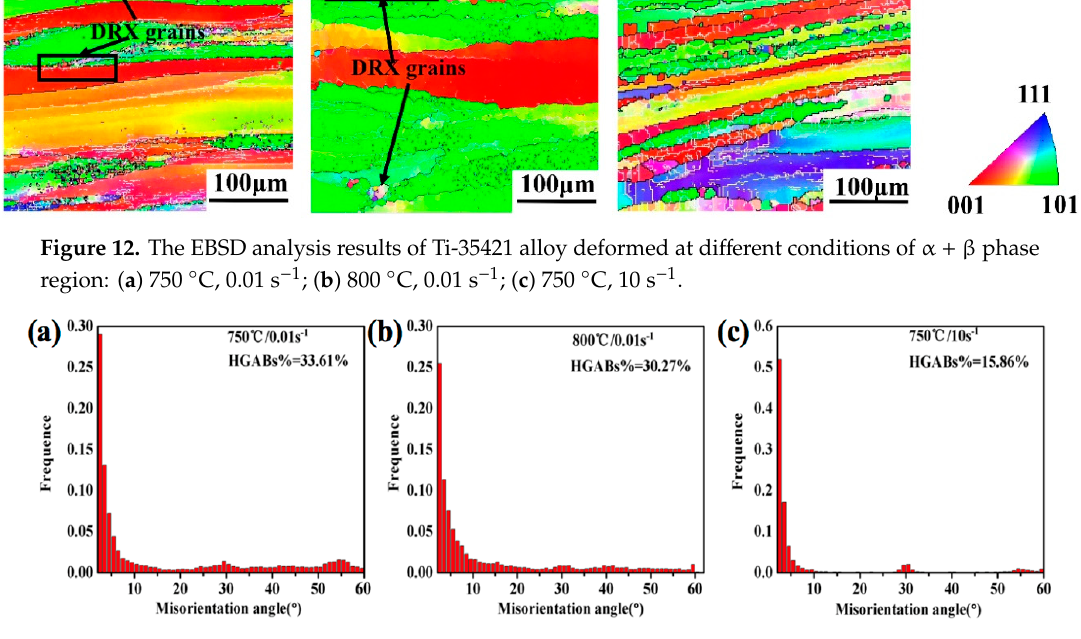
Figure 13. The relative fraction of low angles grain boundaries (LAGBs) and high angles grain boundaries (HAGBs) under different deformation conditions of α + β phase region: ( a ) 750 °C, 0.01 s − 1 ; ( b ) 800 °C, 0.01 s − 1 ; ( c ) 750 °C, 10 s − 1 .